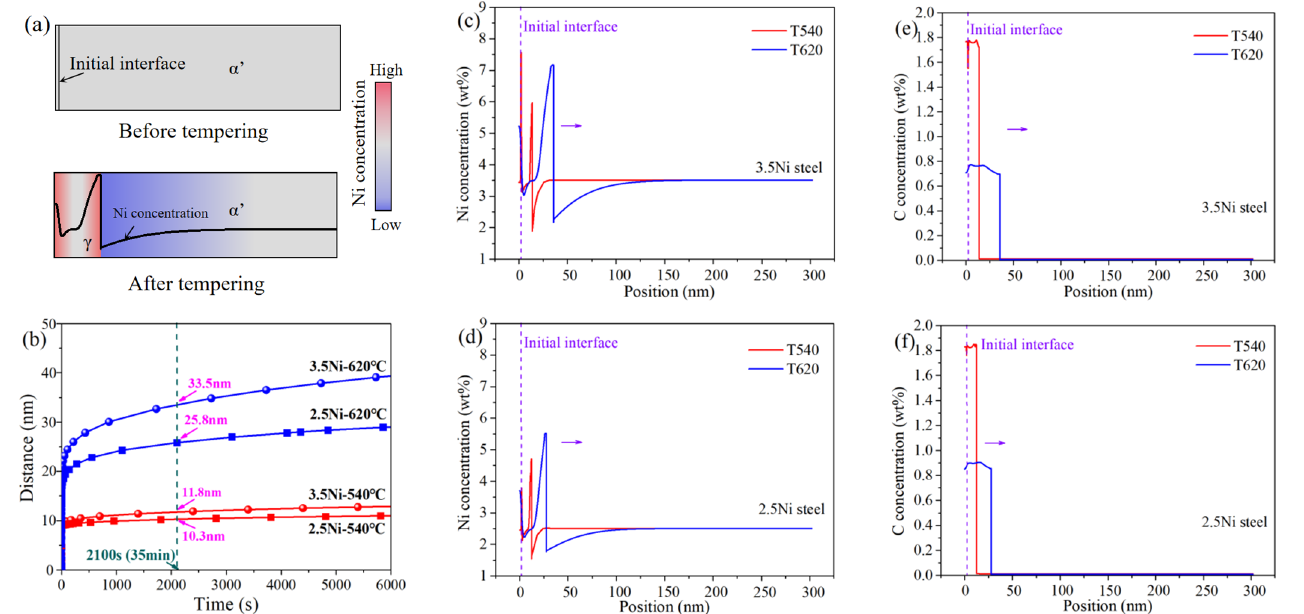
Figure 6. ( a ) The schematic diagram of movement of austenite/martensite interface during austenite reverted transformation. ( b ) Relationship between interface moving distance and tempering holding time. ( c – f ) Variation of concentration profiles of Ni and C with tempering temperature.